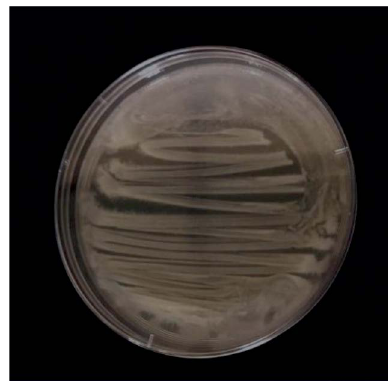
Fig. 2. Isolate (F 15) Optimization of culture conditions of the selected bacteria for PHB production Effect of different media on growth and production of